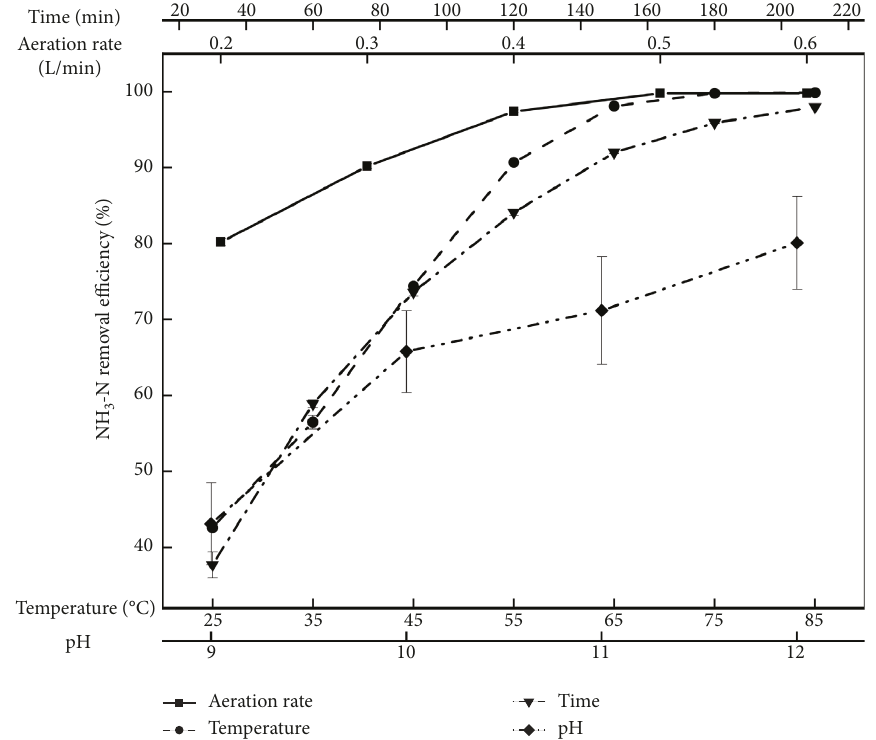
Figure 1: Relation of NH 3 -N removal efficiency with pH, aeration rate, temperature, and time.